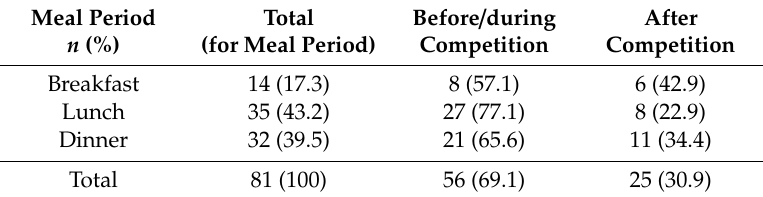
Table 2. Meals tested across meal periods and competition